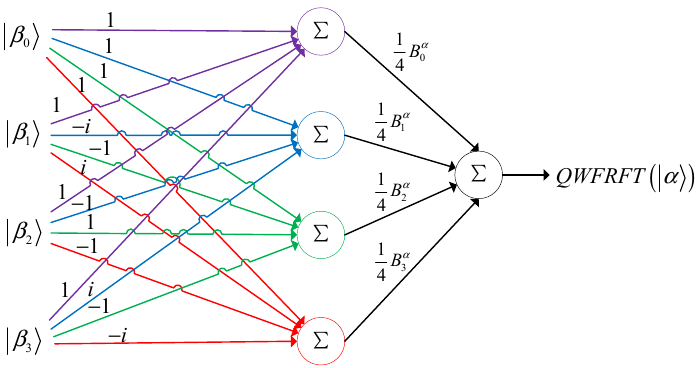
Figure 11. A circuit for the QWFRFT .